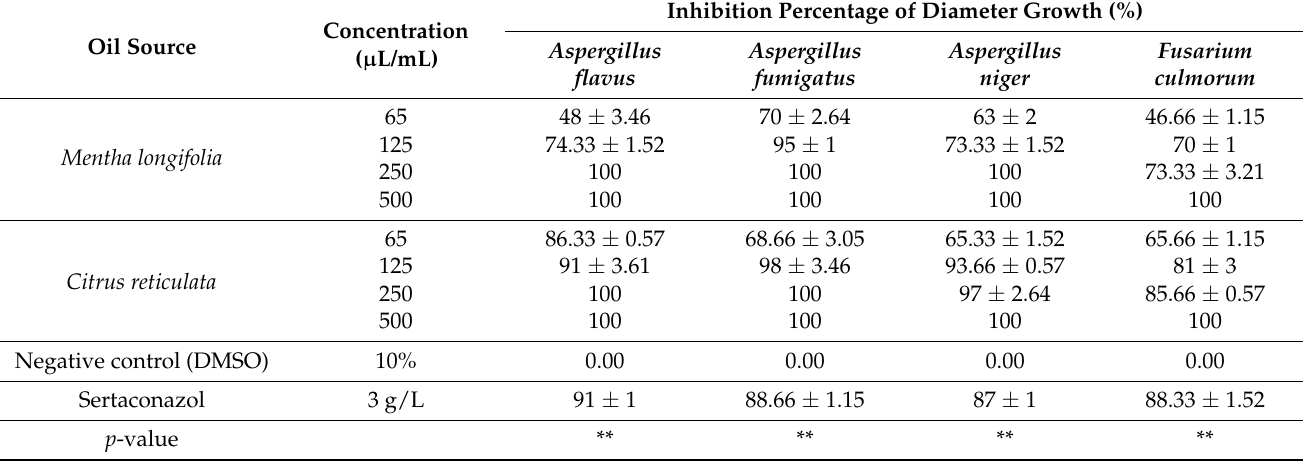
Table 4. Inhibition percentage of the diameter growth of A. flavus , A. niger , A. terreus , and F. culmorum , as affected by essential oils (EOs) from Mentha longifolia and Citrus reticulata